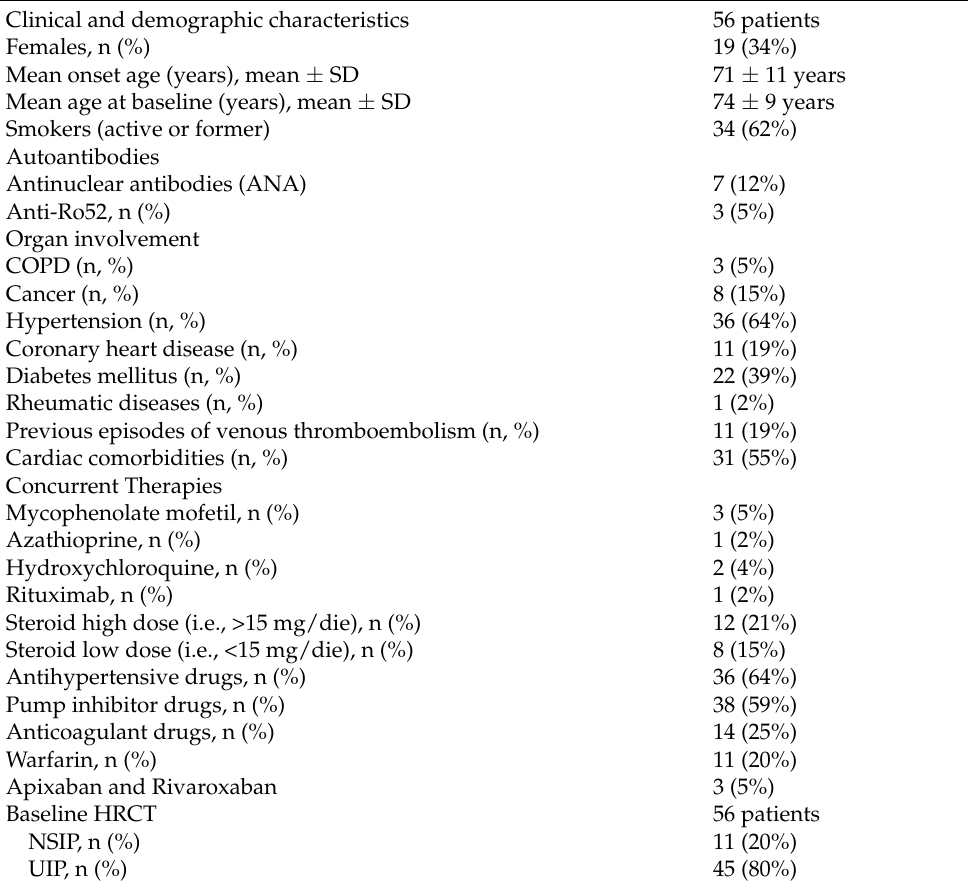
Table 3. Clinical and demographic characteristics of our cohort of IPF